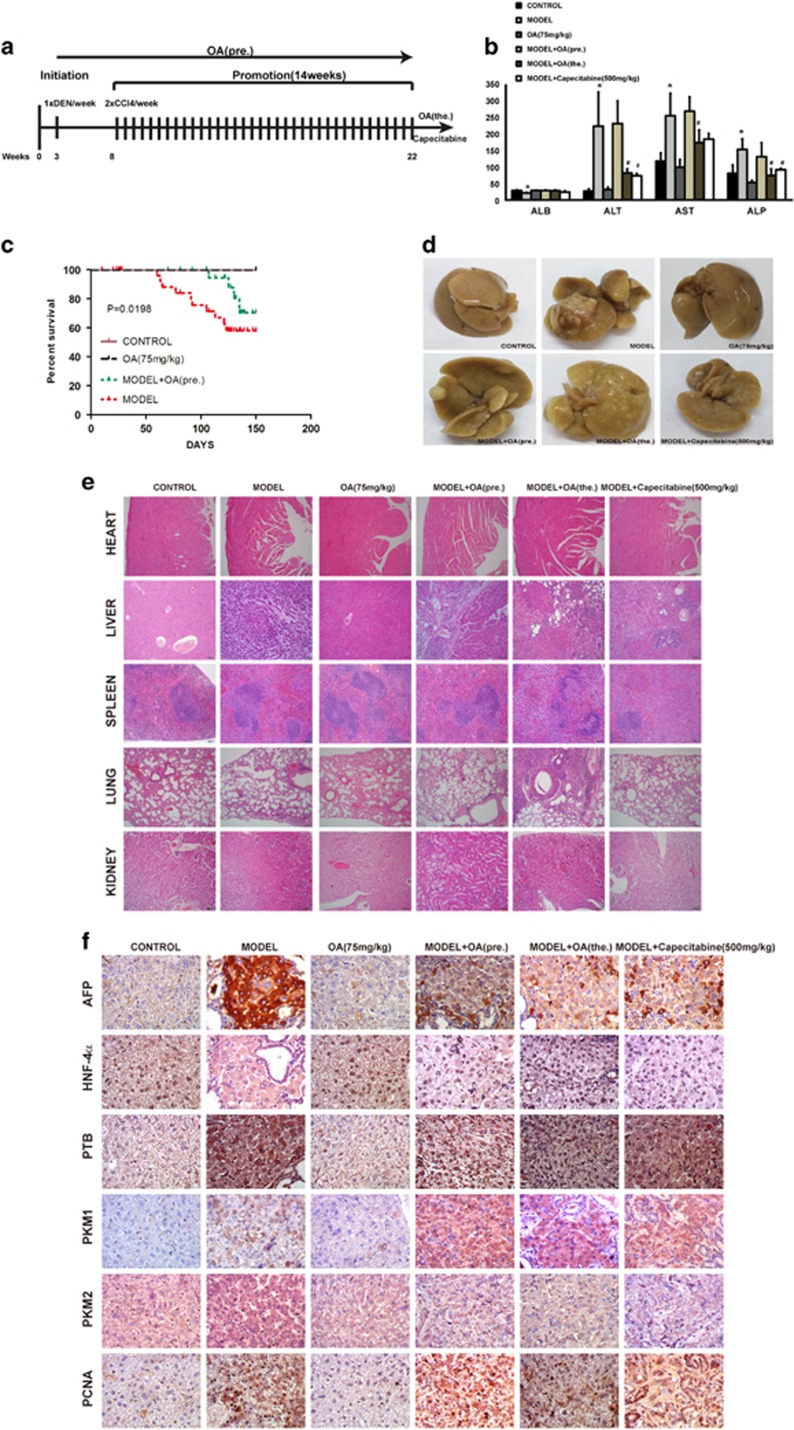
OA slowed down the development of primary liver cancer in the DEN/CCl4-induced mouse model. (a–f) C57BL/6 mice were subjected to a DEN/CCl4-based primary liver cancer induction protocol. OA (pre.) means mice treated with 75 mg/kg OA (i.g.) to study the prevention effect of OA; and OA (the.) means the mice treated with 300 mg/kg OA (i.g.) to study OA’s therapy effect. (a) Diagram shows the experimental procedures of DEN/CCl4-induced mouse model. (b) The contents of ALB, ALT, AST and ALP in plasma were measured. (c) Survival percents during modeling were shown. *P<0.05 model+OA(pre.)group compared with model group. (d) Representative images of livers were shown. (e)Hearts, livers, spleen, lungs and kidneys were retrieved and sectioned for HE staining (magnification, × 200). (f)Immunohistochemistry analysis of AFP, PTB, PK1, M PKM2, HNF-4α and PCNA (magnification, × 400). Bars, SD. *P<0.05 or **P<0.01 compared with control group; #P<0.05, ##P<0.01 compared with model group